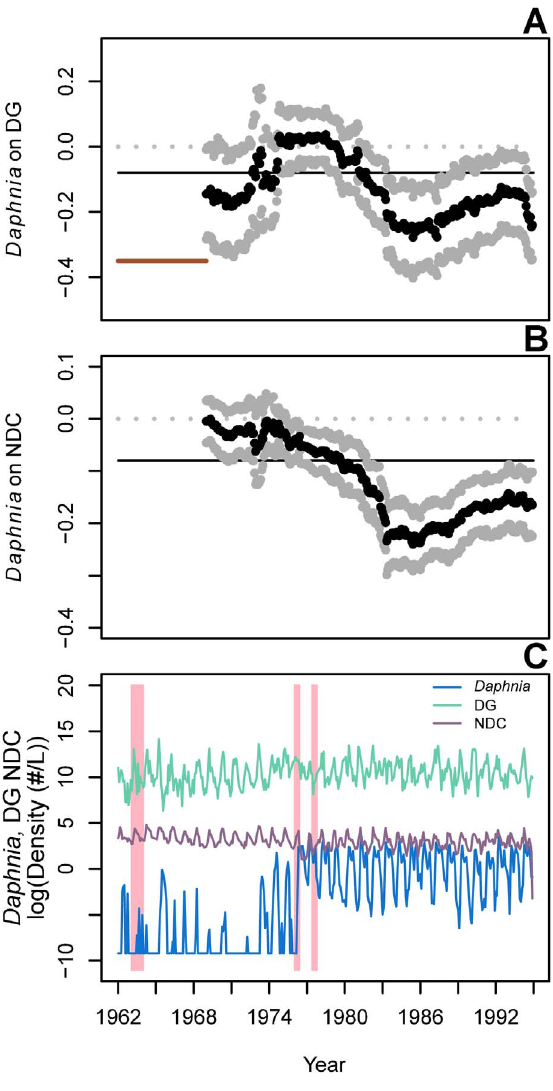
Figure 2. Shifting effects of Daphnia on the Lake Washington plankton community. Effects of Daphnia on diatoms and green algae, DG, (A) and non-daphnid cladocerans and non-cladoceran crustaceans, NDC, (B) through time as estimated by a mwMAR model with an 84-timestep window (indicated by solid red horizontal line in A). Estimates are shown with 95% upper and lower CIs. Grey dotted lines indicate coefficient values of 0; solid black lines indicate the average interaction across the full time series, as estimated by a traditional MAR model. The raw time-series data are given in (C), with years of influential known changes shown in shaded vertical bars. All results are presented at the end year of the moving window.